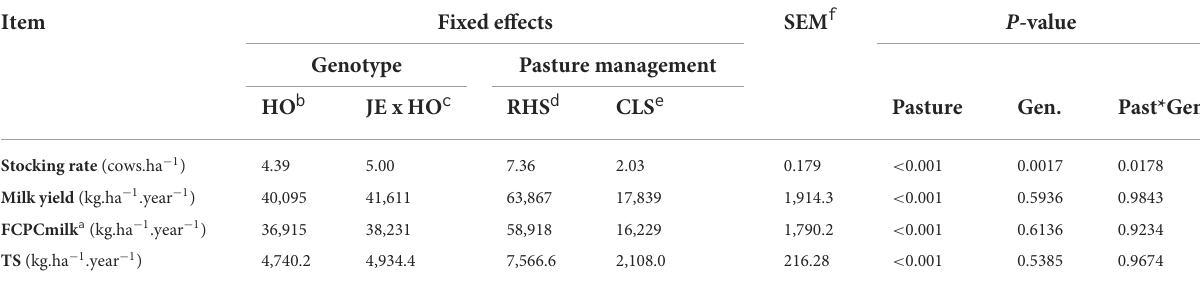
TABLE 2 Stocking rate, milk yield, and its components for two cow genotypes and two levels of intensification in grazing systems. Item